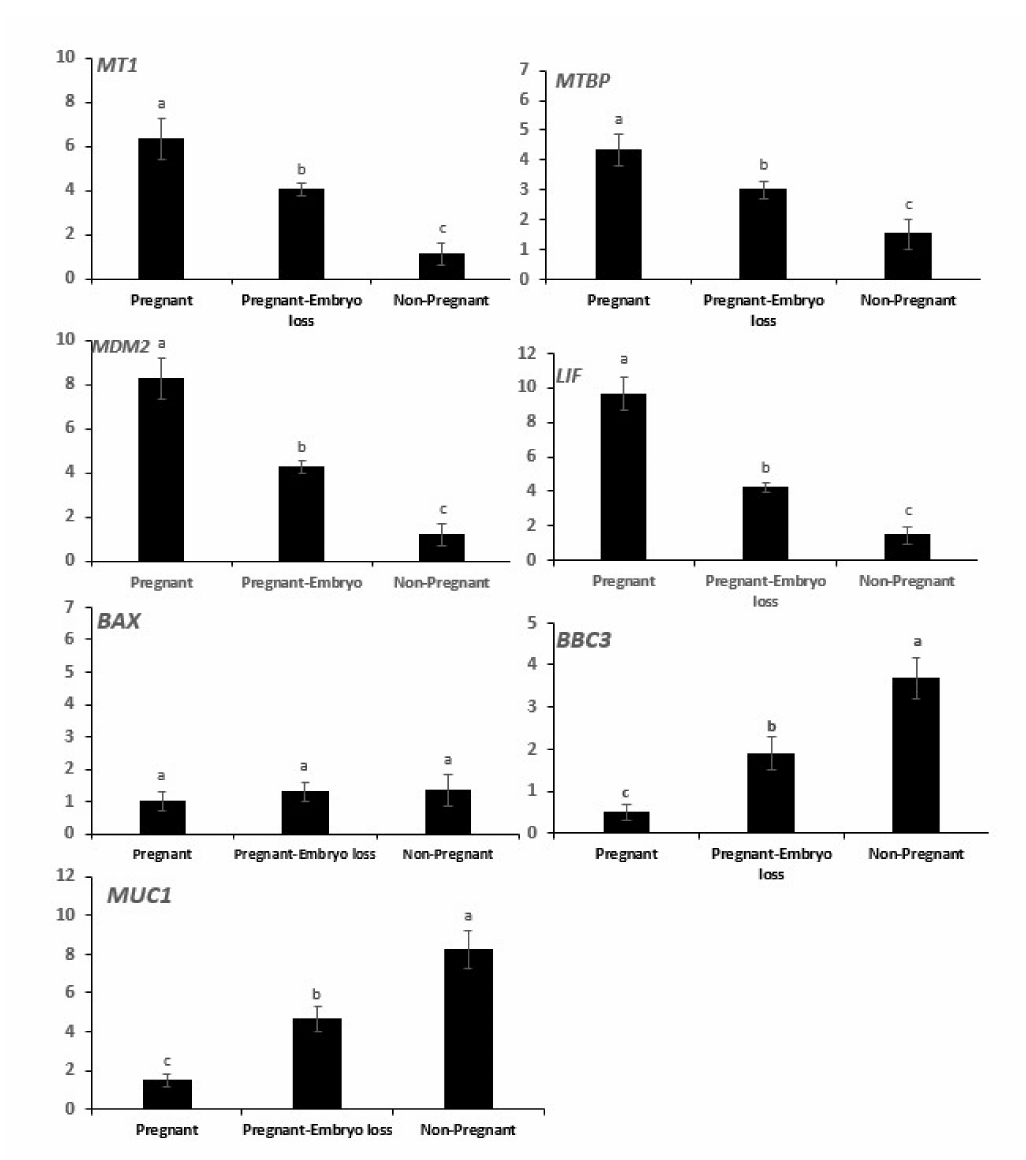
expressions of intraluminal endometrial cells (i.e., r = 0.89 to 0.973, or − 0.972 to − 0.977; Table 2). An examination of Standard Partial Correlations (Table 2) detected 6 of 21 correla- tions (29%) in which partial correlations adjusted for ISG15 (i.e., MTBP/MUC1 , MTBP/LIF , BAX/MUC1 , BAX/LIF , BBC3/LIF , LIF/MT1 ) were lower than the respective simple correla- tions (Table 1). This is indicative that ISG15 gene expression in blood cells was associated with differential expression of specific genes in specific intraluminal endometrial cells.